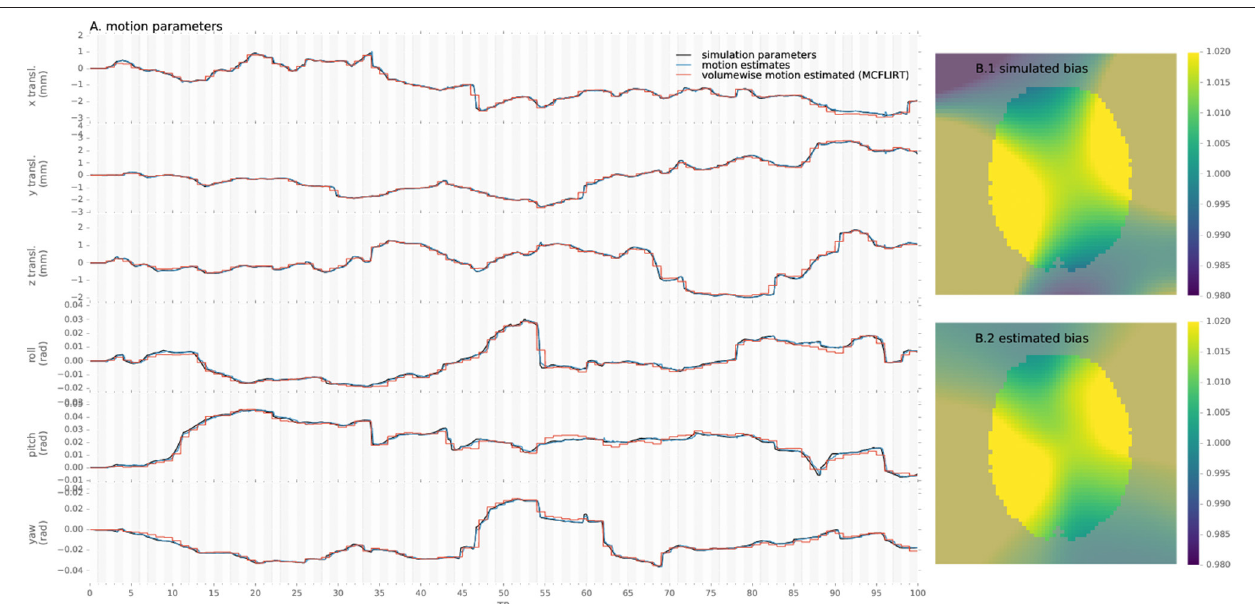
FIGURE 2 | Example of motion parameters and bias simulated and estimated by the proposed algorithm and conventional volume-wise